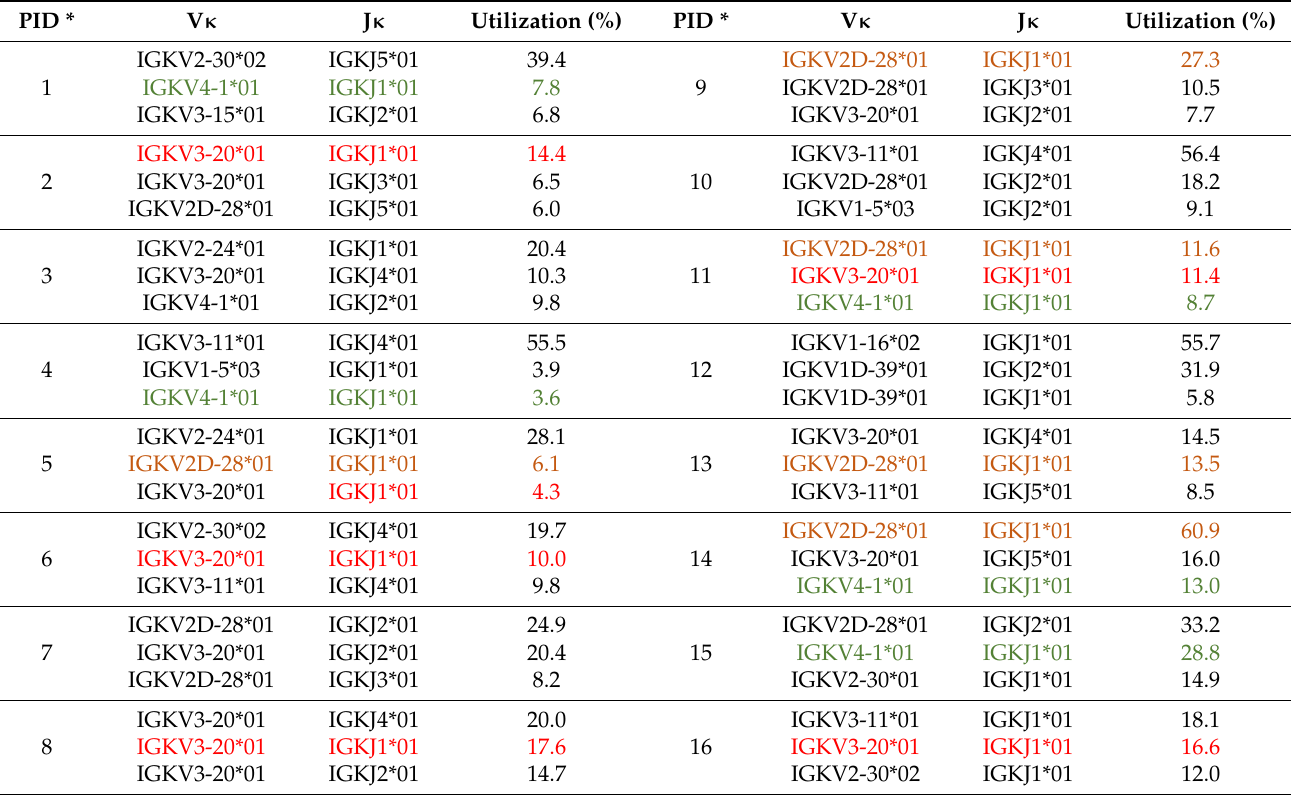
Table 1. The top three V κ -J κ patterns used by AML